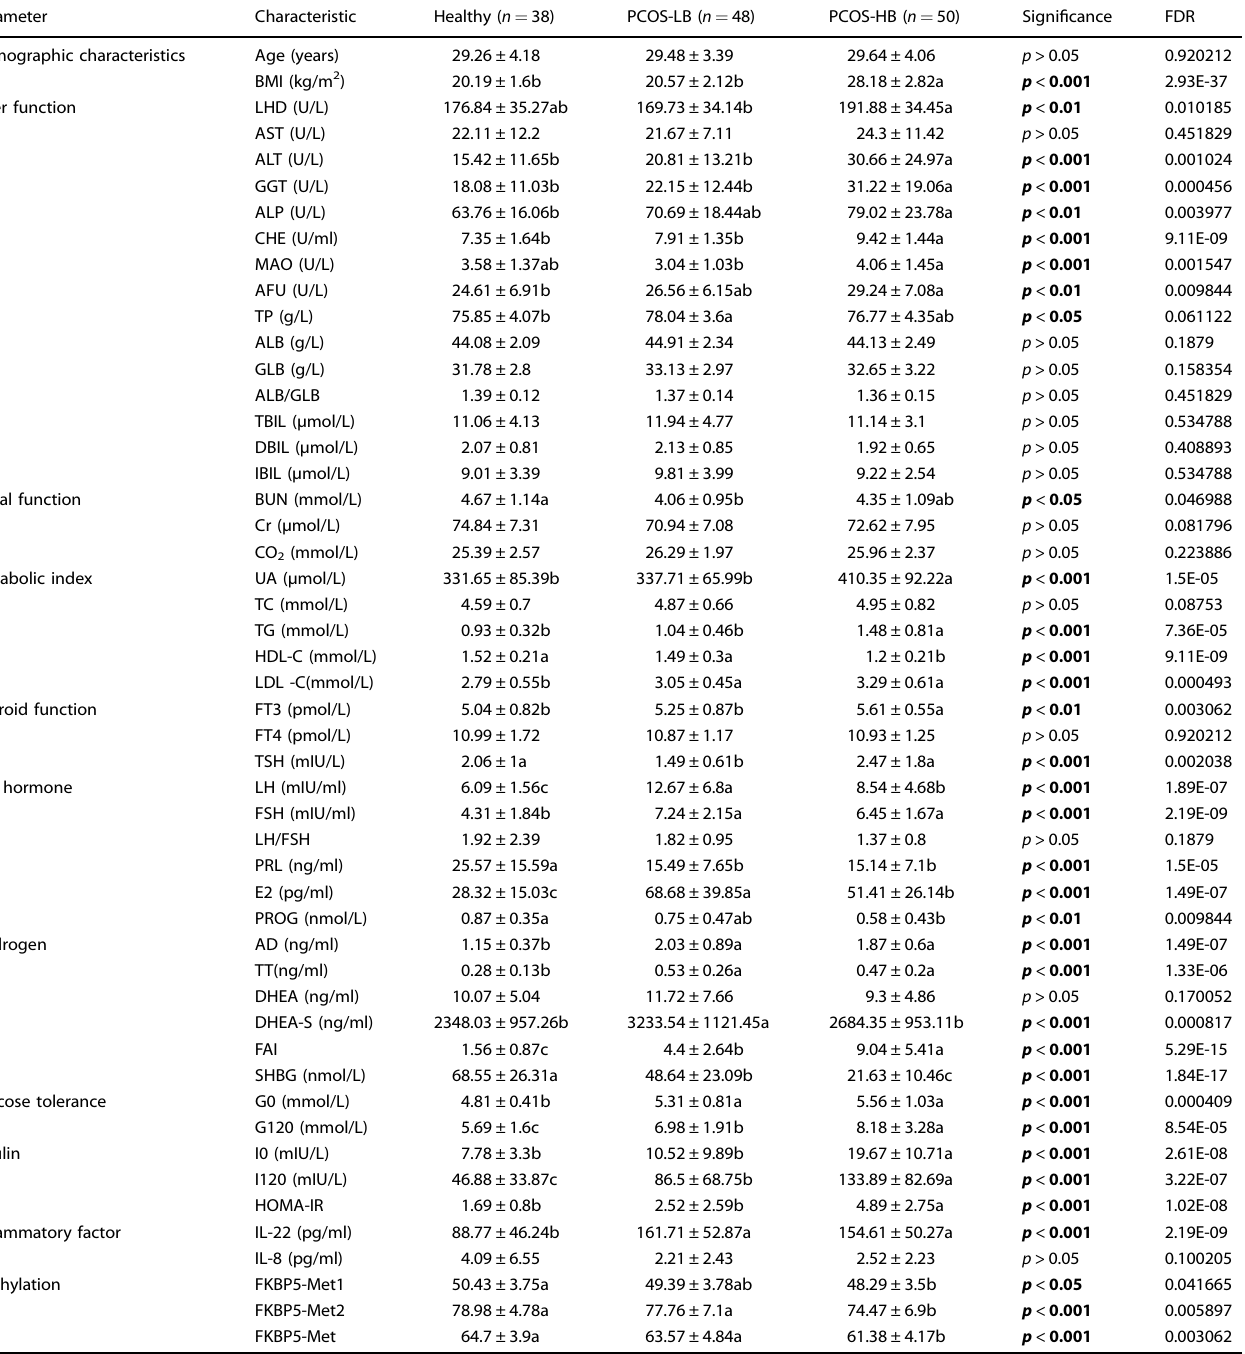
Table 1. Clinical characteristics baseline in the healthy and PCOS